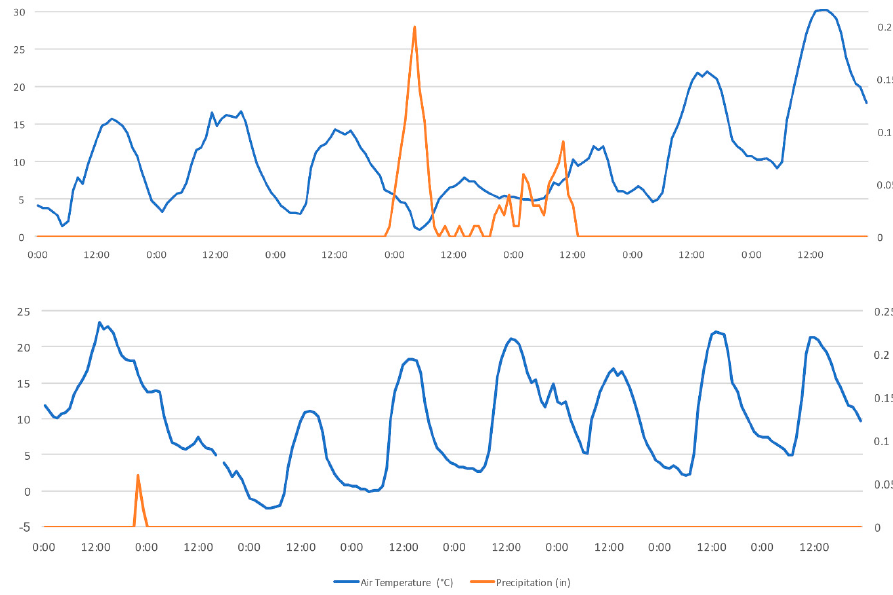
Figure 14. ( top ) Air temperature and precipitation at the Mascoma River for the week leading up to 11 May 2017 ( bottom ) Air temperature and precipitation at the Mascoma River for the week leading up to 22 October 2017.